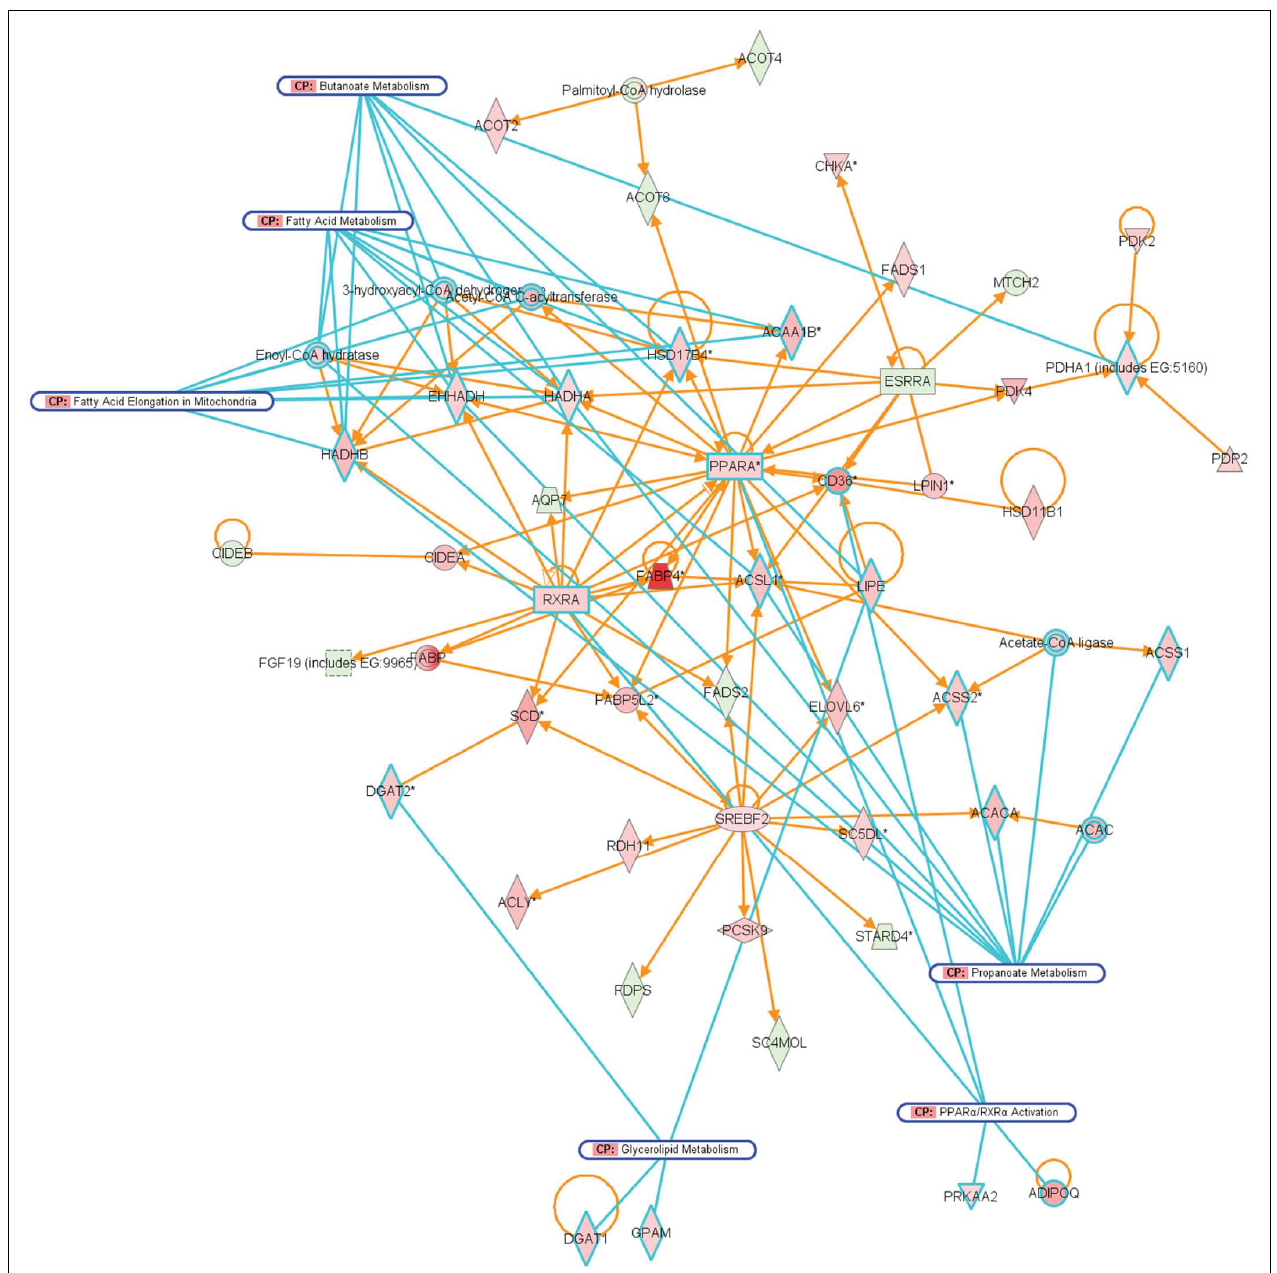
co-expressed with the major regulators, PPAR and RXR are up-regulated, or up-regulated through the activity of the sterol regulatory element binding transcription factor 2